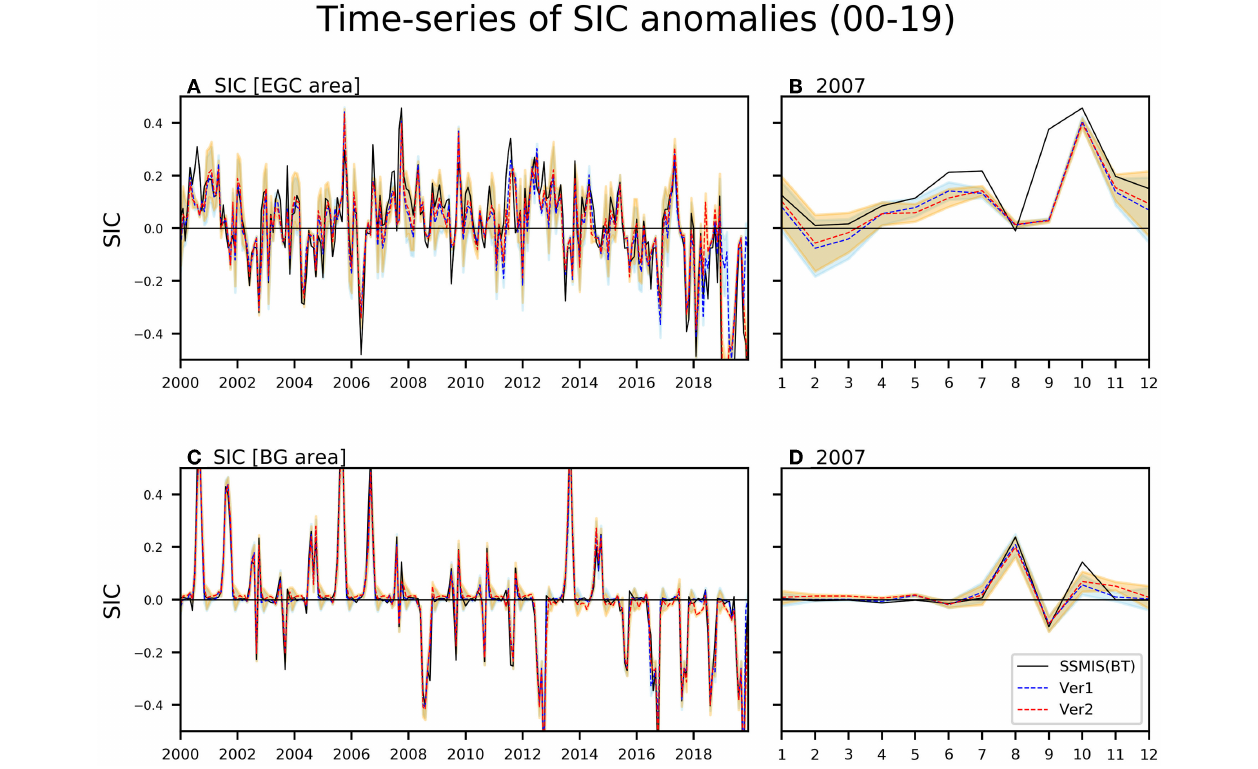
FIGURE 4 | The temporal evolution over 2000–2019 (A,C) and in 2007 (B,D) of sea ice concentration anomalies (a fraction from 0 to 1) for observation (black) and background states of Ver1 (blue) and Ver2 (red) at a grid point used in Figure 3 ( A,B : 75 ◦ N, 10 ◦ W in East Greenland Current area; C,D : 75 ◦ N, 150 ◦ W in Beaufort Gyre area). The orange (skyblue) shading marks the uncertainty (standard deviation) of the ensemble